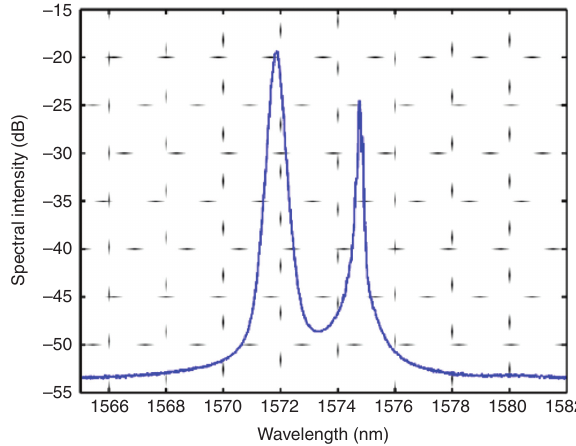
Figure 2: Optical spectrum of dual-wavelength continuous wave emission of the fiber